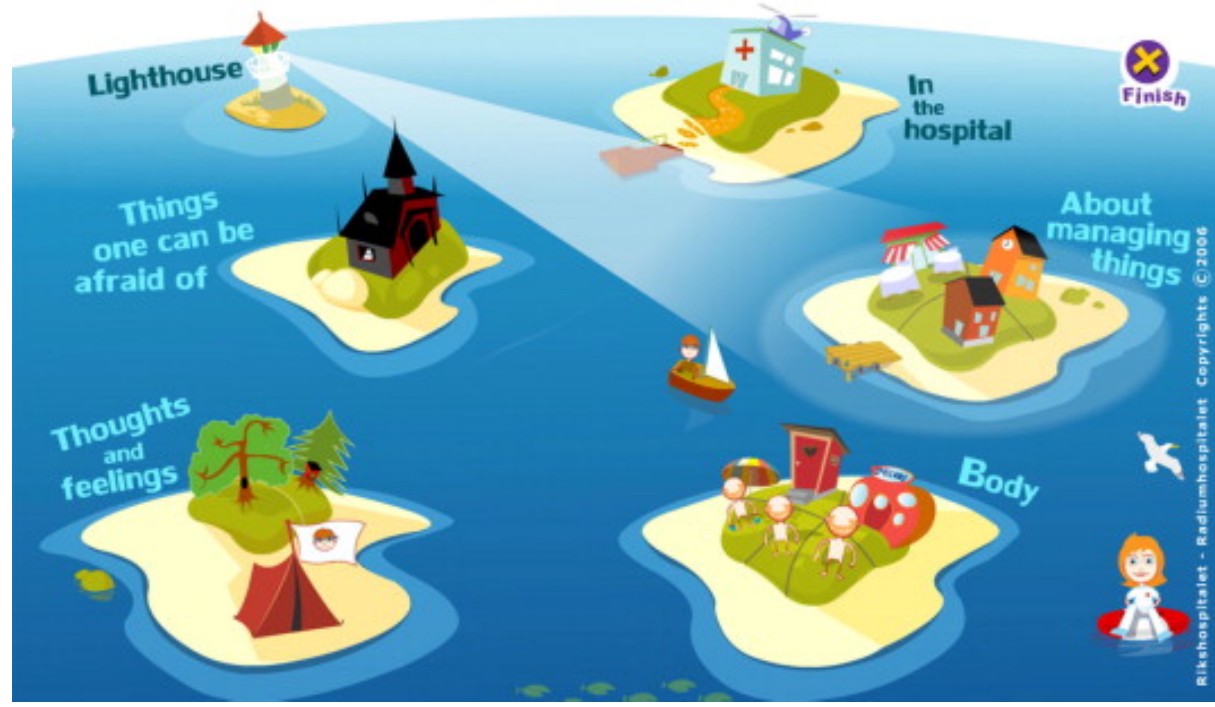
Figure 1. The 5 islands of Sisom.